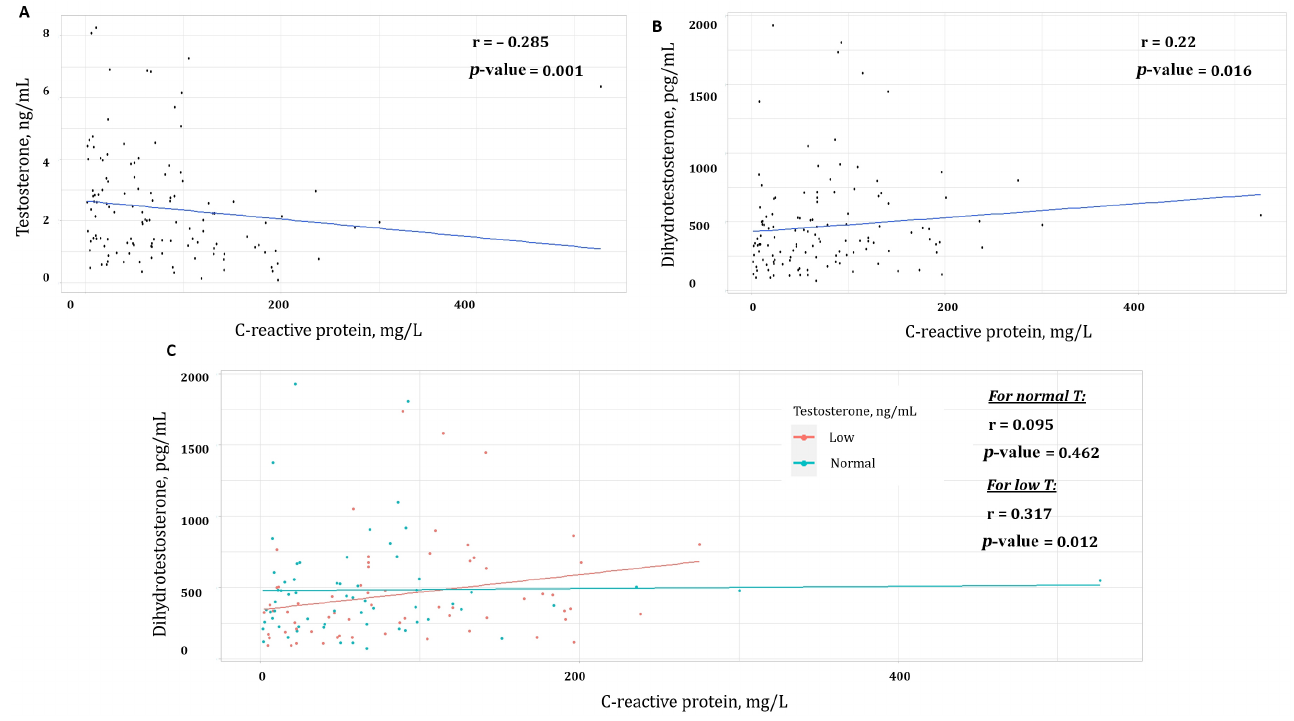
FIGURE 3. Correlation analysis for T, DHT and CRP. (A)—correlation between T and CRP. (B)—correlation between DHT and CRP. (C)—correlation between DHT and CRP in 2 groups according to T levels. pro-inflammatory effect of DHT, because of there are not correlation between DHT and CPR in group of normal T (r = 0.095; p =